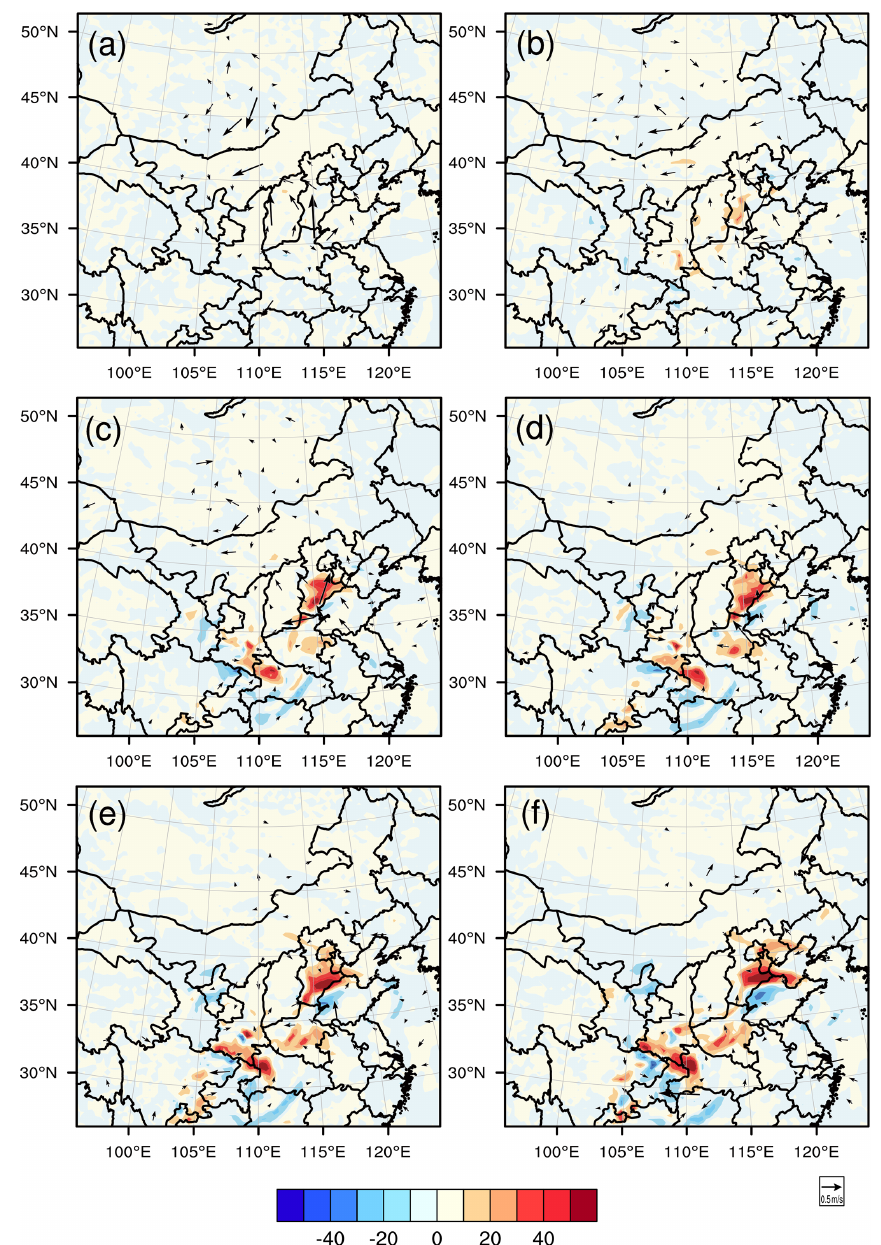
Figure 12. The spatial evolution of the forecast differences of ground wind (vector, ms − 1 ) and PM 2 . 5 concentrations (shaded, µgm − 3 ) between the assimilation run (CNOP-EXP with an observing distance of 90km) and the control run starting from 02:00BJT 1 December, with lead times of (a) 1h, (b) 6h, (c) 11h, (d) 16h, (e) 21h and (f)